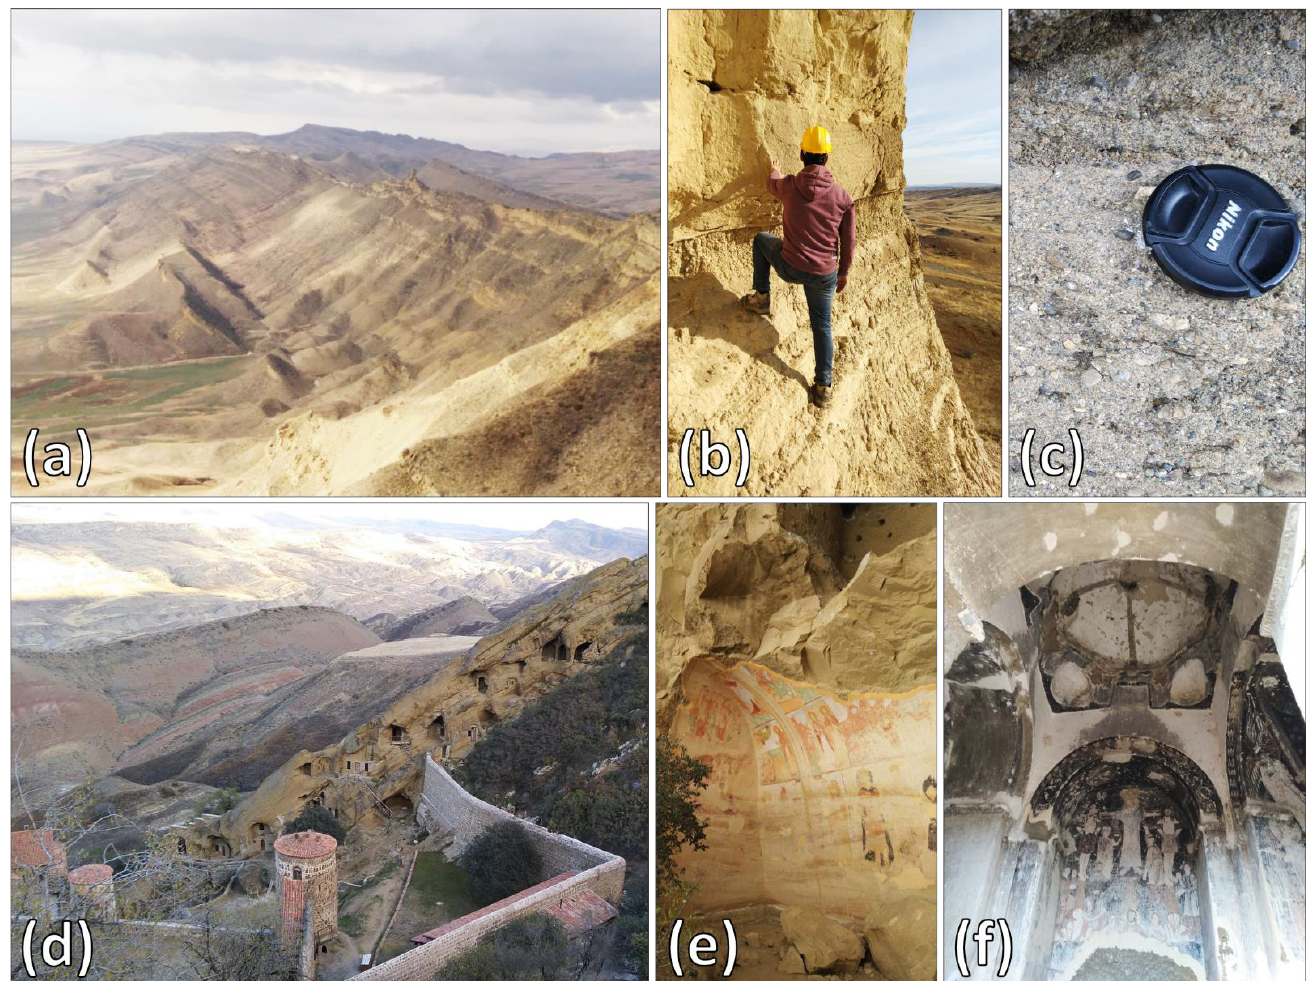
Figure 3. The David Gareja area: structural monocline ( a ); outcropping lithologies (silts and clays with thick sand layer ( b ) coarse-grained sands-conglomerates ( c ); Lavra monastery ( d ); Examples of frescoed cave chapels in the monasteries of Udabno ( e ) and Sabereebi ( f ).